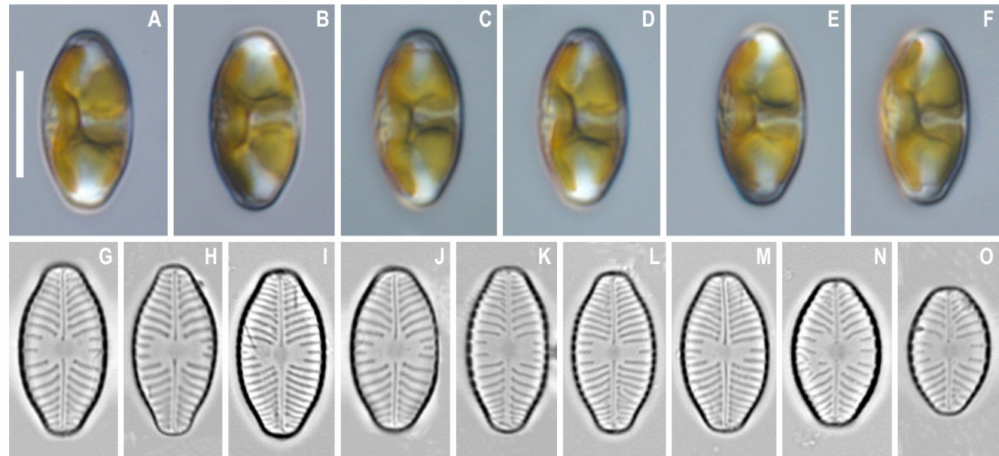
Figure 2. Placoneis baikaloelginensis Kezlya, Glushchenko, Kulikovskiy & Kociolek sp. nov. Strain B708, slide no. 01498. ( A – O ). Light microscopy, differential interference contrast, size diminution series. ( A – F ). Live cells with chloroplast structure. Scale bar = 10 µ m.